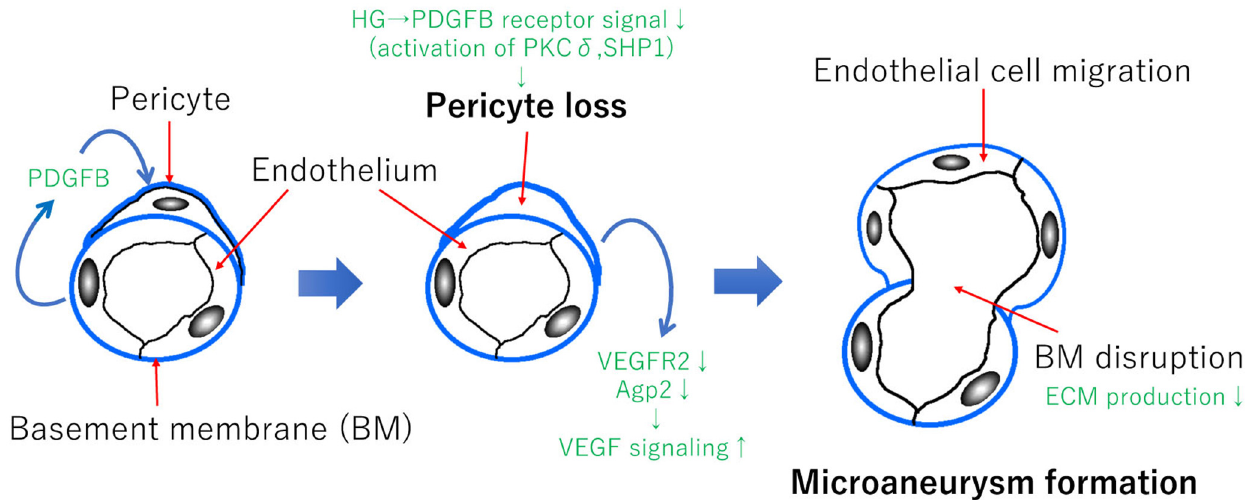
Figure 2. Hypothetical scheme of microaneurysm formation. PDGFB released from endothelial cells recruit pericytes and make the BRB formation during the process of retinal vascular development [53,54]. Chronic hyperglycemia reduces the PDGFB receptor signaling followed by pericyte apoptosis via activation of PKC δ and increased expression of SHP1 [55,56]. These molecular events lead to pericyte loss, which results in reducing VEGFR2 and angiopoietin-2 signaling [55,56]. As a result, VEGFA signaling is increased, which may cause endothelial cell migration. The BM in the retinal vessels is composed of ECM components, including fibronectin, collagen IV, and laminin derived from endothelial cells and pericytes [58]. In general, chronic hyperglycemia or high glucose conditions promote the synthesis of the ECM components, which results in an increase of vascular permeability [58–60]. However, pericyte loss may cause a disruption of the BM locally because of a reduction of ECM production only in the area of the pericyte loss. Taken together, microaneurysms may be formed, as shown in Figure 2. PDGFB: platelet-derived growth factor B; HG: hyperglycemia; PKC δ : protein kinase C δ ; SHP1: Src homology 2 domain-containing phosphatase-1; VEGFR2: vascular endothelial growth factor receptor 2; Agp2: angiopoietin-2; ECM: extracellular